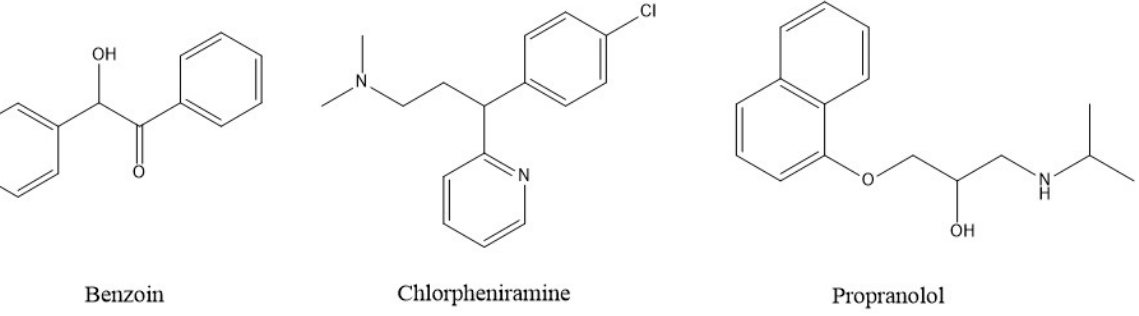
Figure 1. Structures of compounds used in this study.